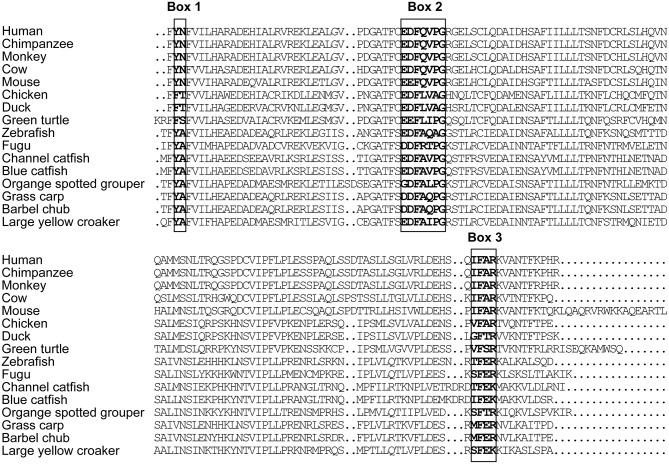
Alignment of TRIF TIR domain sequences from human (accession number NP_891549.1), chimpanzee (accession number NP_001123604.1), monkey (accession number AAS20428.1), cow (accession number NP_001025472.1), mouse (accession number AAH33406.1), chicken (accession number NP_001074975.1), duck (accession number NP_001297720.1), green turtle (accession number XP_007072279.1), zebrafish (accession number ABP04048.1), fugu (accession number NP_001106665.1), channel catfish (accession number NP_001187154.1), blue catfish (accession number ABH10662.1), orange spotted grouper (accession number AEX01719.1), grass carp (accession number AGW25589.1), and barbell chub (accession number AMP81962.1).